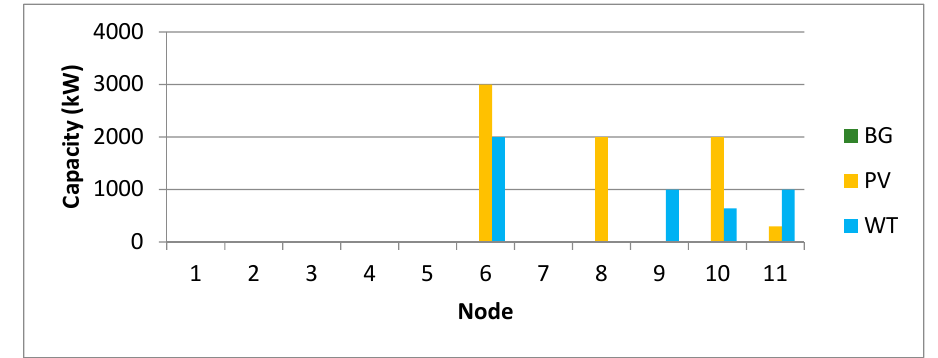
Figure A2. Capacity structure for 40% share of energy from RES in total demand with sizing and allocation of RES only.